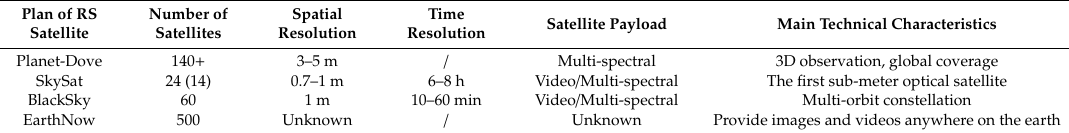
Table 1. Plans of Remote Sensing Satellite Constellations